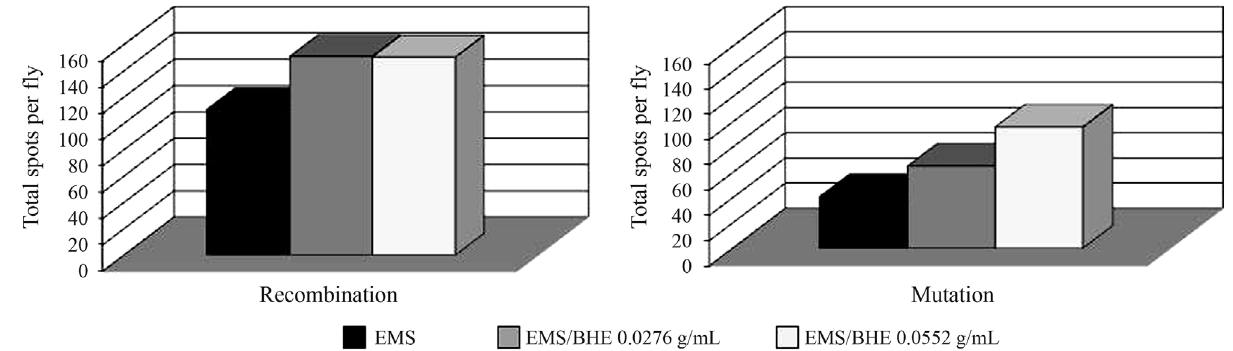
Figure 1 - Contribution of mutation and recombination to the frequency of total spots per fly in trans-heterozygous flies treated with EMS in combination (co-treatment) with BHE (0.0276 and 0.0552 g/mL). The recombinogenic activity was calculated according to Sinigaglia et al. (2004, 2006) as follows: Mutation frequency (F M ) = frequency of spots in balancer-heterozygous/frequencies of spots in marker-trans-heterozygous. Recombination frequency (F R )=1-F M .Frequencyoftotalspots(F T )=totalspotsin mwh / flr 3 flies(considering mwh and flr 3 spots)/numberofflies.Mutation=F T XF M .Recombina- tion = F T X F R